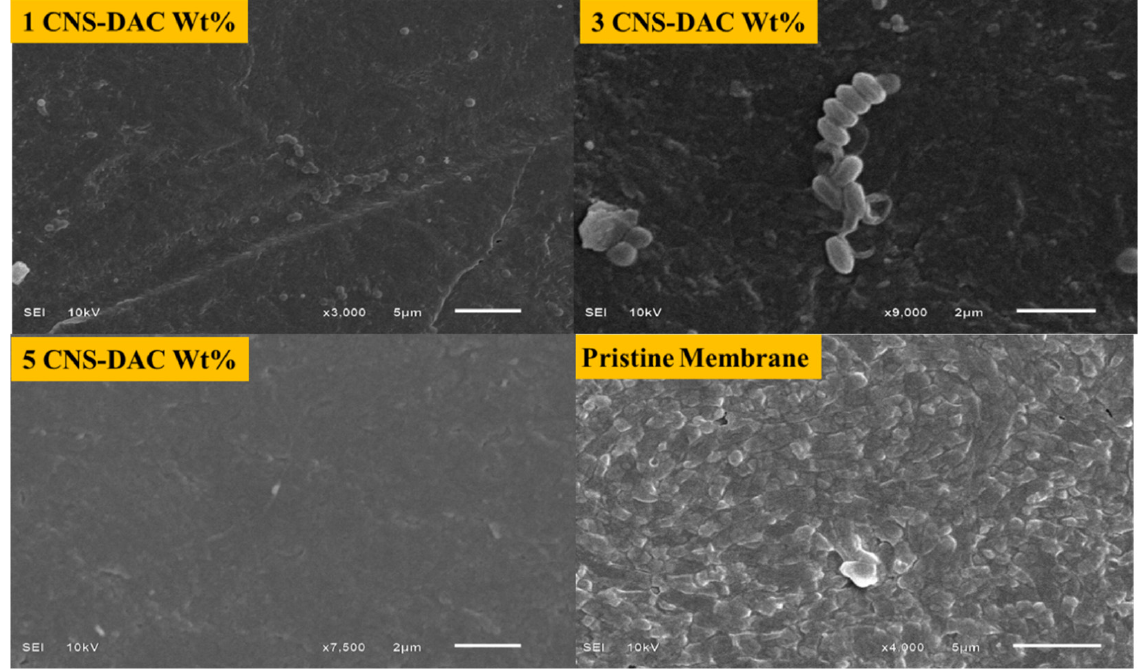
Figure 10. Bacterial adhesion and growth on the pristine membrane, the CNS-DAC membrane at different CNS loading (wt.%) for a period of up to 120 h.